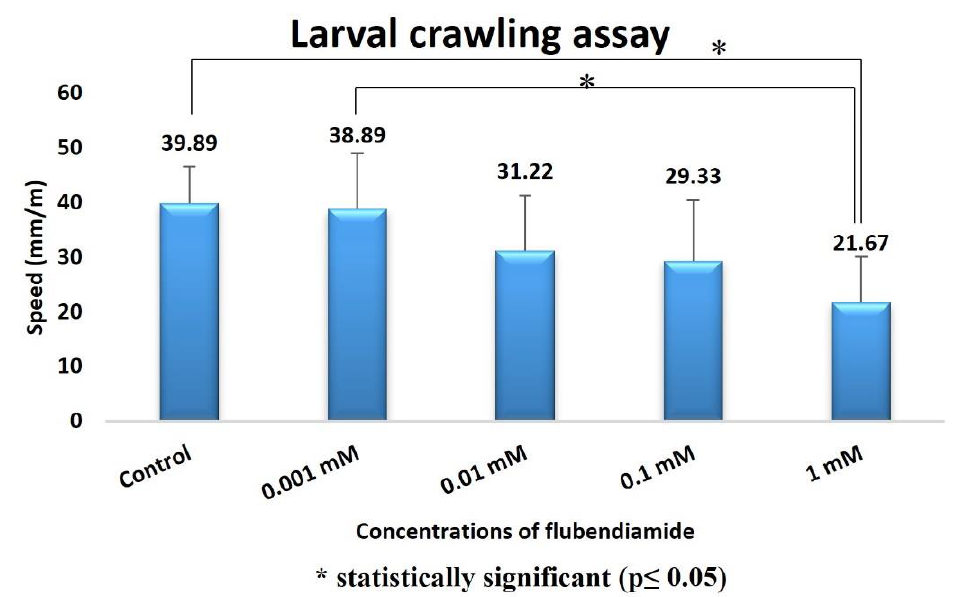
Figure 6. Effect of FLB exposure on larval crawling of D. melanogaster .